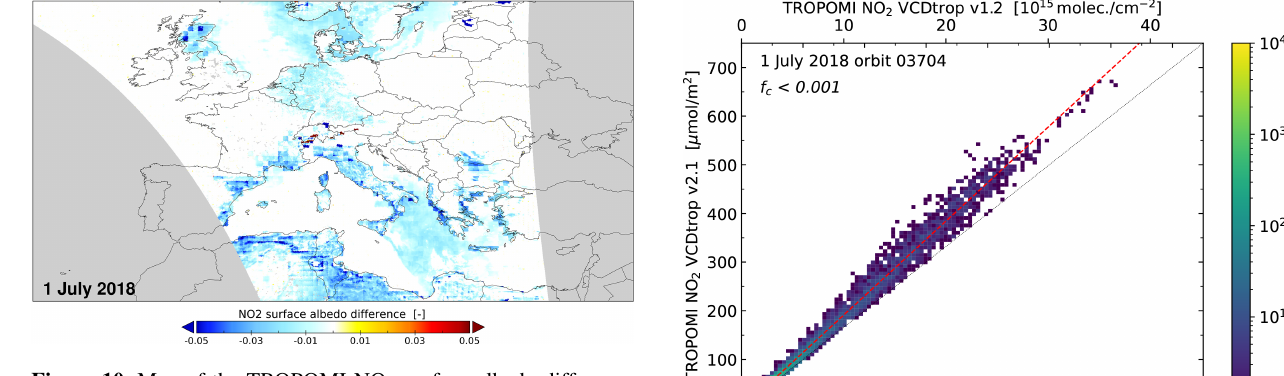
Figure 10. Map of the TROPOMI NO 2 surface albedo difference “v2.1 minus v1.2” of a part of orbit 03704 of 1 July 2018. See the text for further details. The depicted area is longitude [ − 20 to + 40 ◦ ], latitude [ + 30 to + 60 ◦ ].